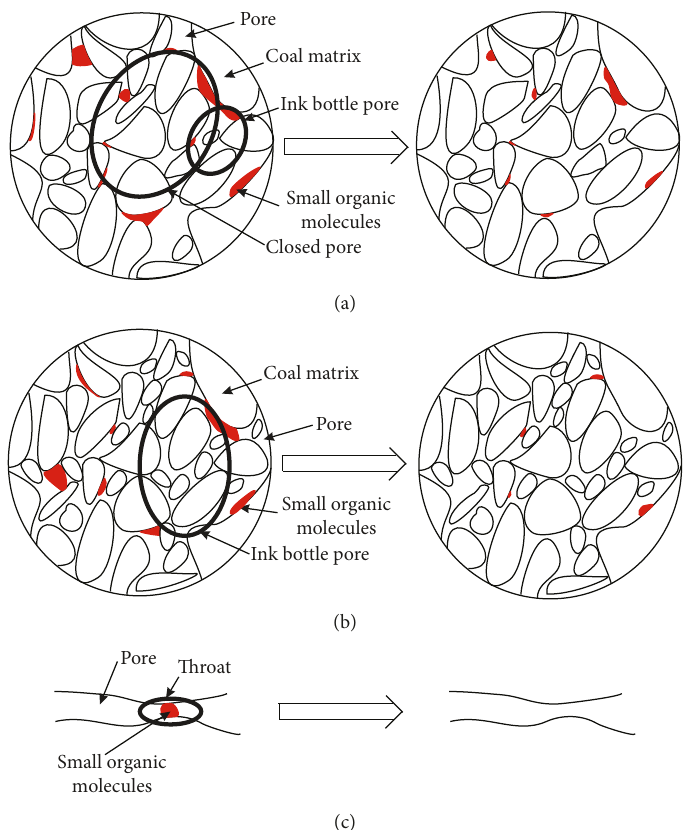
Figure 9: A conceptual mechanism of pore structure for CS (b) pore structure changes for CS